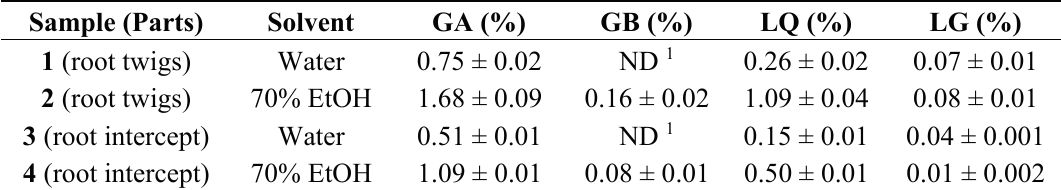
Table 1. Comparative active components of licorice